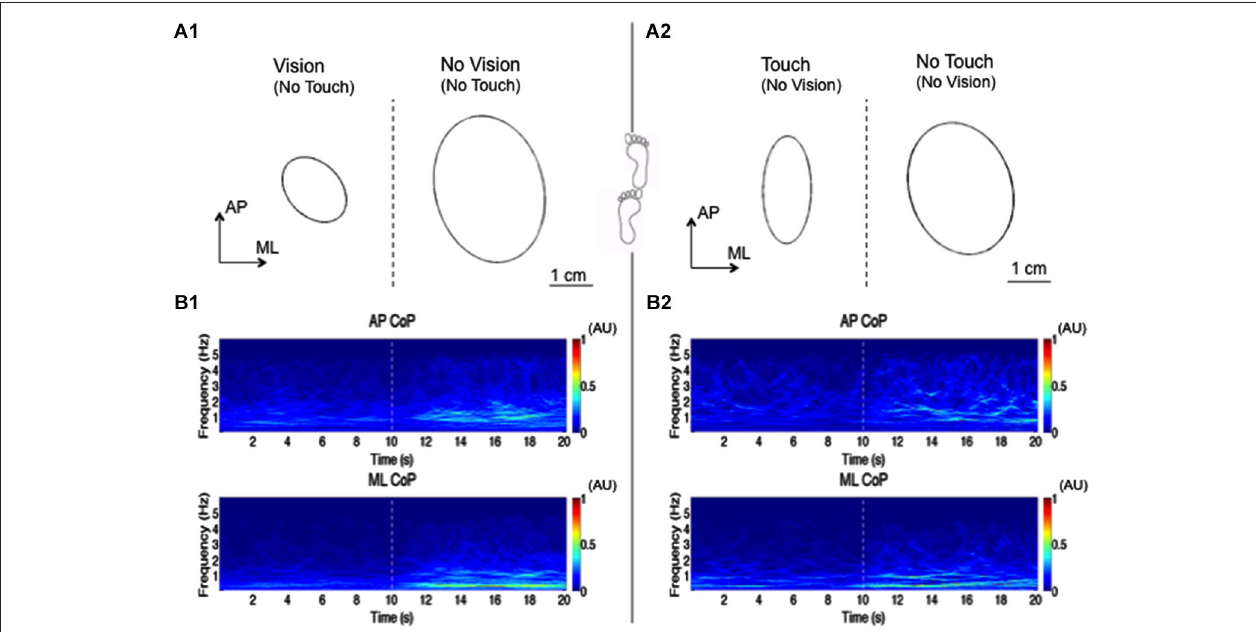
(B1) shows the transform during the vision/no-vision shift, (B2) during the touch/no-touch shift. The wavelet transform seen here is the mean of the transforms of 50 trials. The colors in the Figure represent the amplitude of the wavelet coefficient. Dark red represent the highest while dark blue is the lowest wavelets coefficient. Bins of 0.1 s have been chosen in order to better highlight the temporal changes in the coefficients after the sensory shift. Occluding vision or haptic information increases the wavelet coefficients in the frequencies ranging from 0.2 to 3 Hz, which indicates increase in the amplitude of the ML and AP oscillations. Higher frequency components were added up to the spectrum when sensory information was lost. The changes in the wavelets coefficient start increasing after a delay of approx. 1 s, to reach a stationary state in a few more